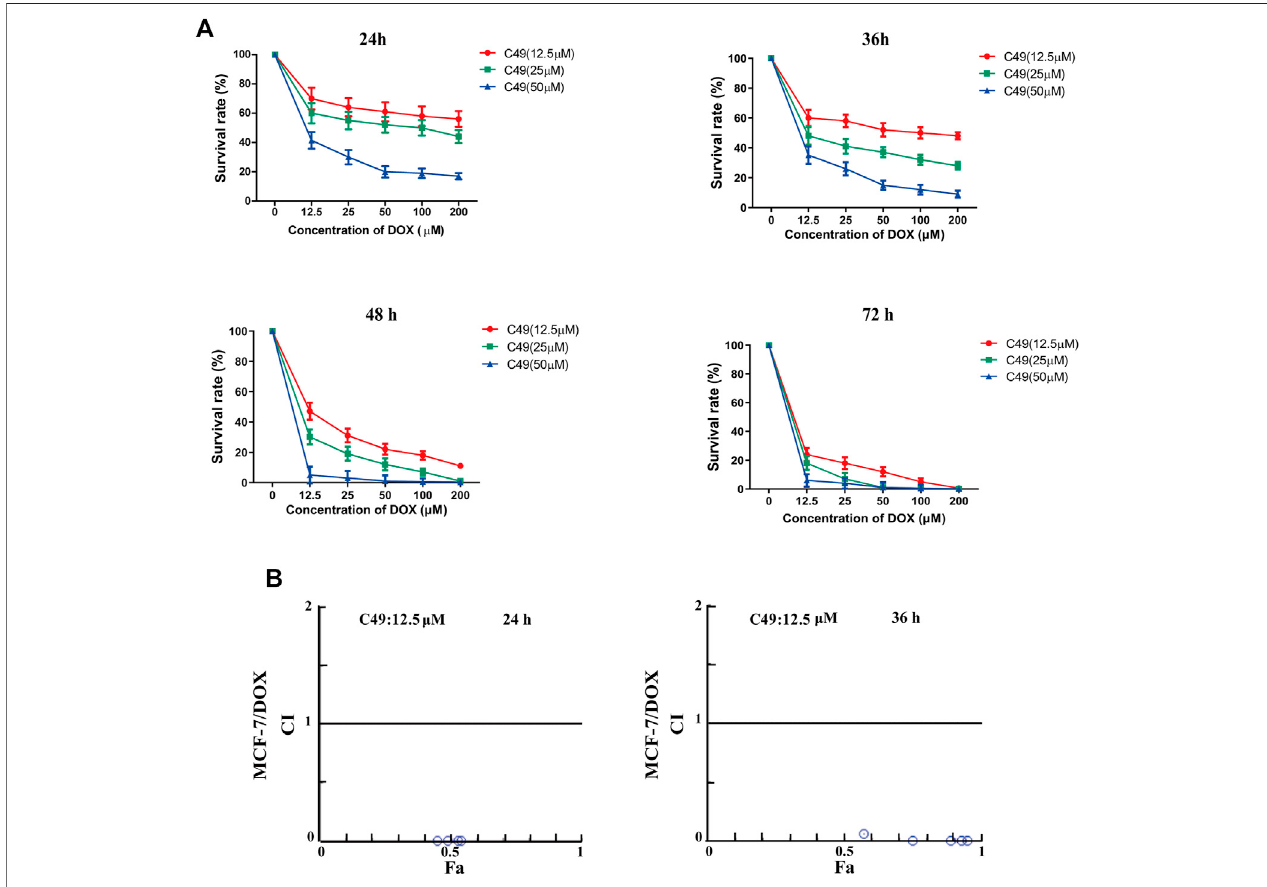
FIGURE2| The effect ofC49combined withDOXontheviabilityofMCF-7/DOXcell. (A) DOXorC49combinedwithDOXinhibits theviabilityofMCF-7/DOX cells. Each point represents mean ± SD, n (cid:1) 3. * p < 0.05, ** p < 0.01 and *** p < 0.001 for DOX treated cells vs. combination treated cells. (B) Compusyn software used to compute the Combination Index (CI). CI values < 1, (cid:1) 1, and > 1 respectively represents synergic, addictive and antagonistic effect.